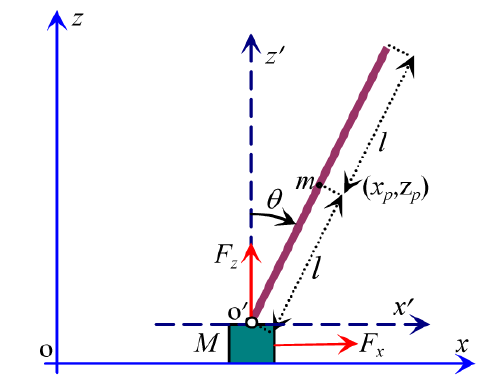
Figure 1. The structure of the X-Z